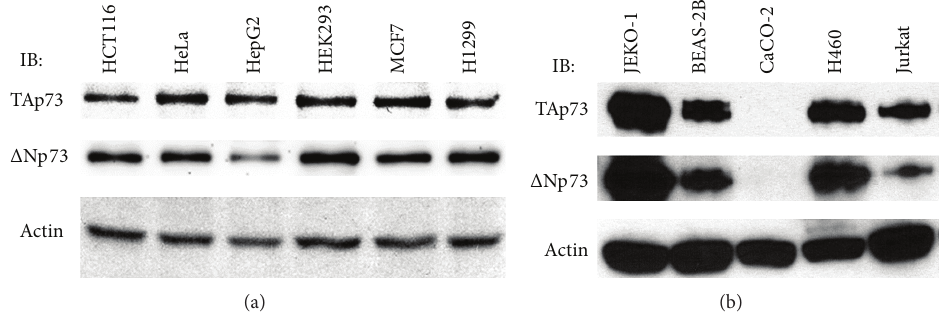
Figure 2: Western analyses of p73 protein N-terminal isoforms in cancer cell lines. Proteins from cancer cell line lysates in Figure 2(a) (1.25 𝜇 g/well) and Figure 2(b) (7.50 𝜇 g/well) were resolved on 10% SDS-PAGE gels and the resolved proteins were electrotransferred onto PVDF membranes and then immunoblotted (IB) with a p73 isoform-specific monoclonal antibody against TAp73 or Δ Np73. As a positive loading control, actin was immunoblotted with a goat polyclonal antibody. Primary antibodies were detected using appropriate secondary antibody-horseradish peroxidase conjugates and an enhanced chemoluminescence method followed by fluorography (IB = primary western